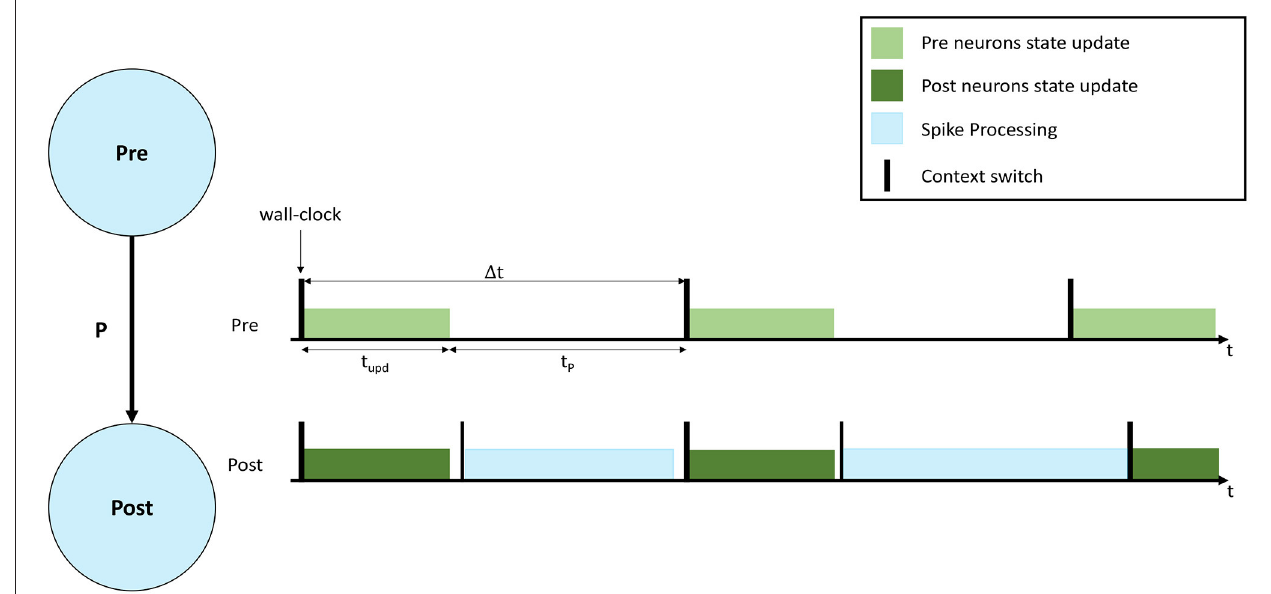
FIGURE 1 | Representation of neural processing. The schematic of a SNN composed of 2 Populations (Pre and Post) with connectivity P is shown on the left . On the right the interaction of simulation events for 3 simulation timesteps, with real-time requirements violation is presented. The green bars show the neural state update, the blue bars the synaptic input